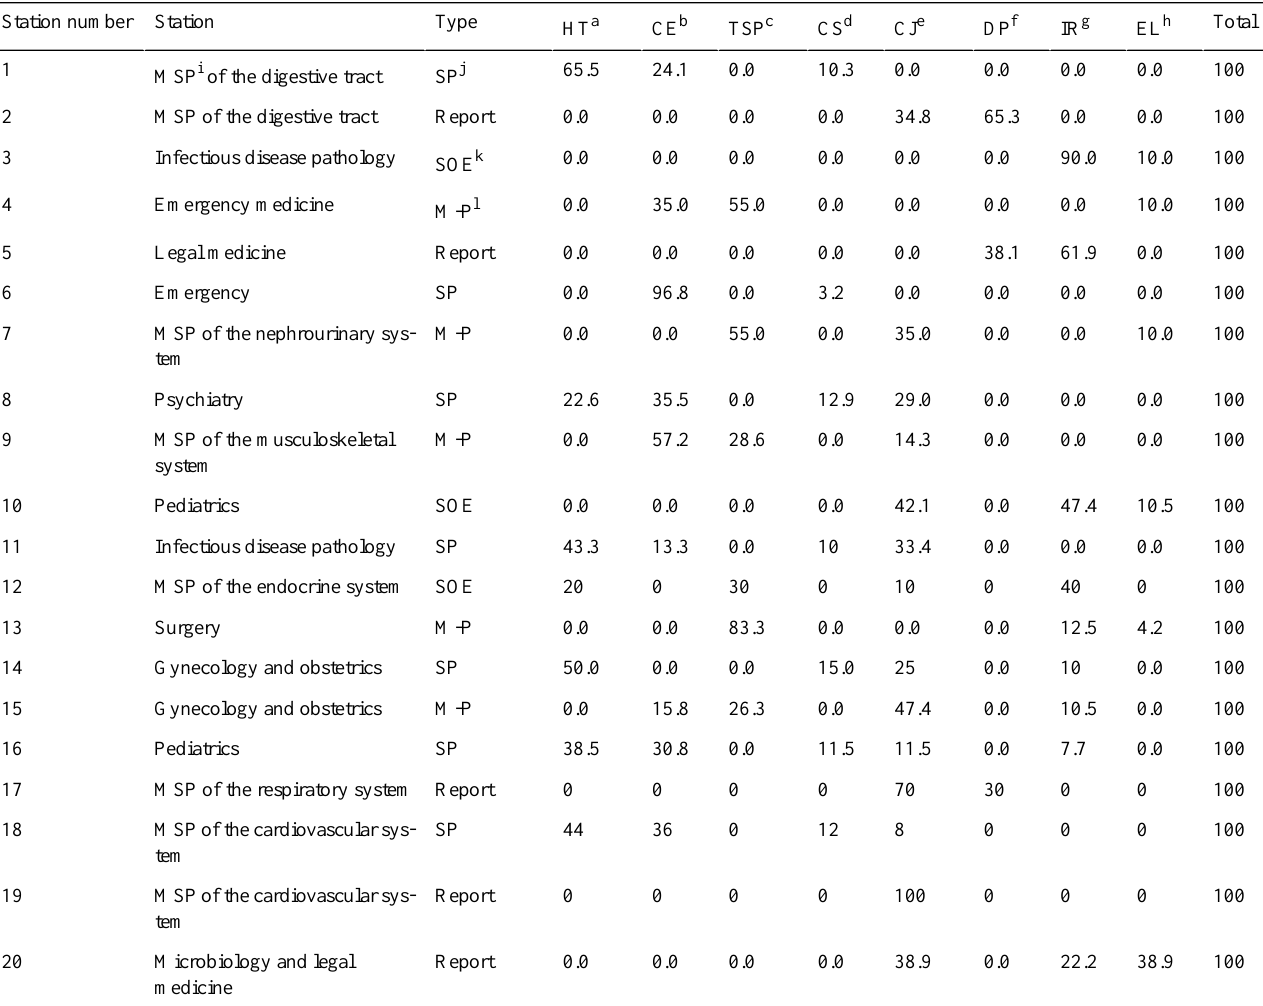
Table 1. Station, type of station, and skills map for the objective structured clinical